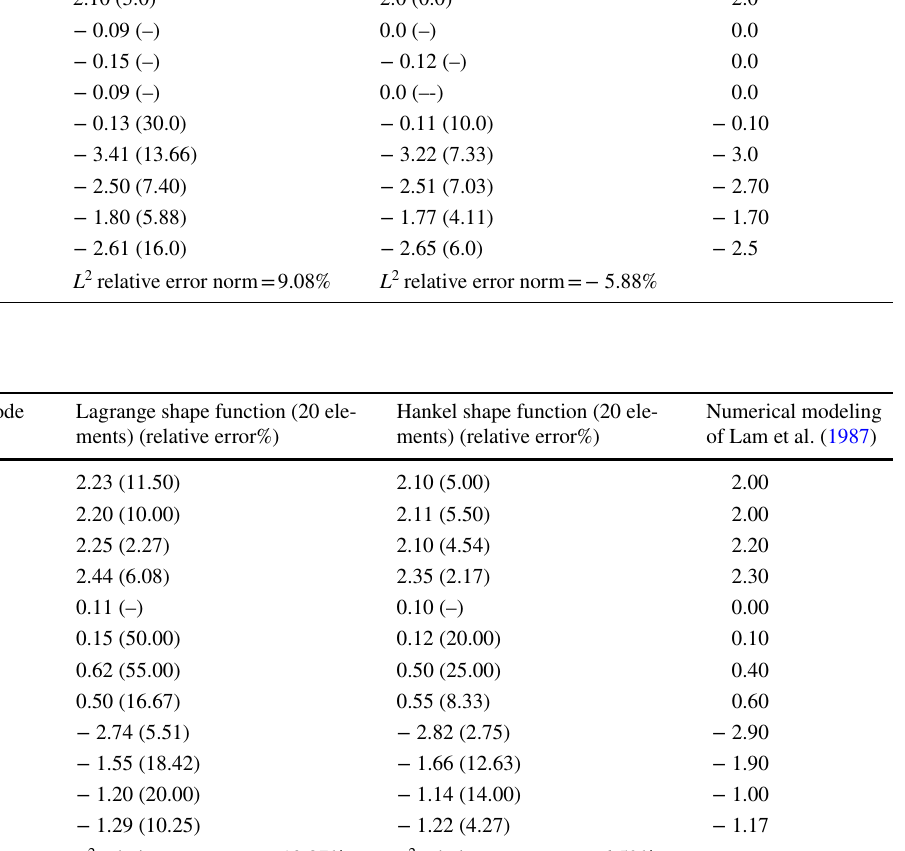
Node Lagrange shape function (20 Ele- results obtained from Hankel ments) (Relative error%) shape function, Lagrange shape function and numerical solution of Lam et al. (1987) t = 66.5 min at for the fifth problem